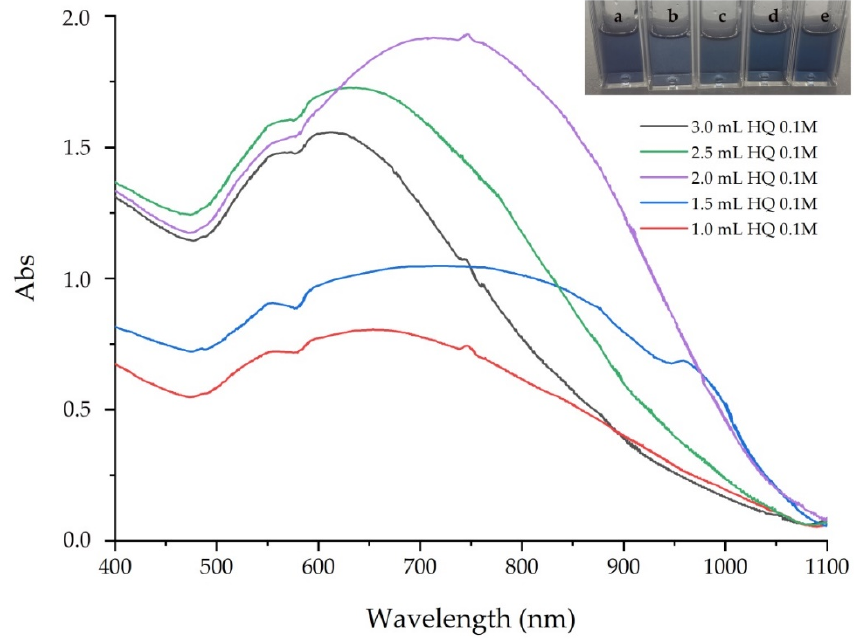
Figure 5. Absorption spectra of GNS prepared in various HQ 0.1 M volume—( a ) 1.0 mL, ( b ) 1.5 mL,